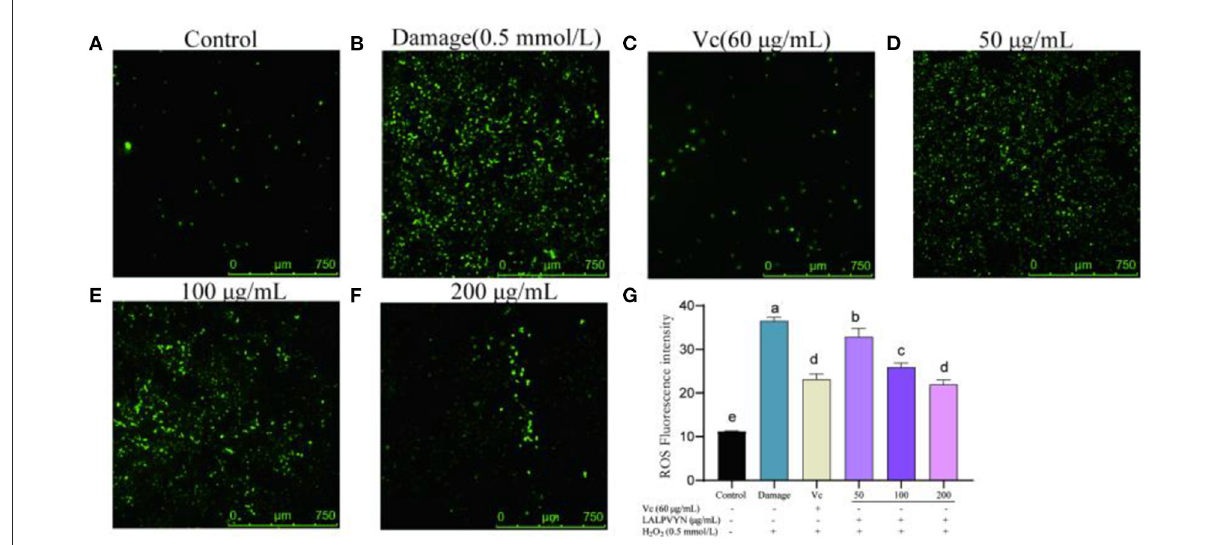
FIGURE6 The effect of LALPVYN pretreatment on ROS of H 2 O 2 -mediated oxidative injured HepG2 cells. (A–F) Pictures were taken by laser scanning confocal microscopy; (G) the average fluorescence intensity was analyzed by Image J. Data are expressed as mean ± SD from three independent experiments ( n = 3), results marked with the same letters were not significantly different ( P > 0.05).